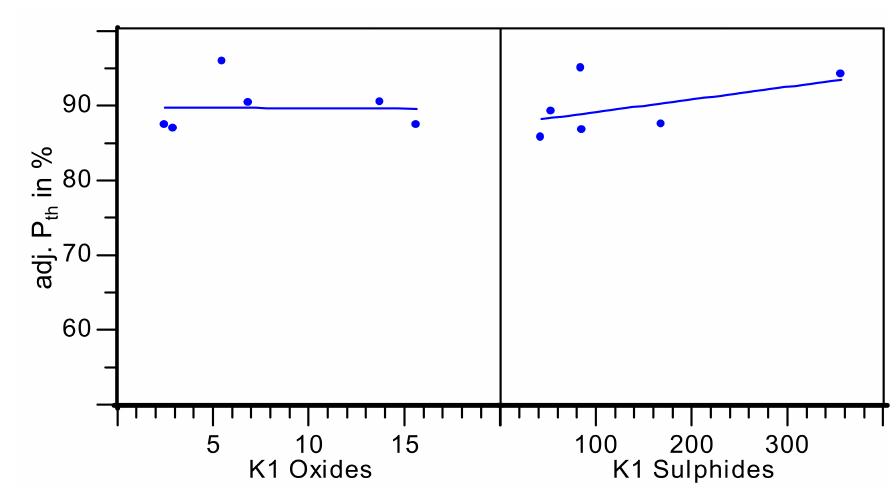
Figure 16. Invariant threshold loads P th depending on degree of purity.